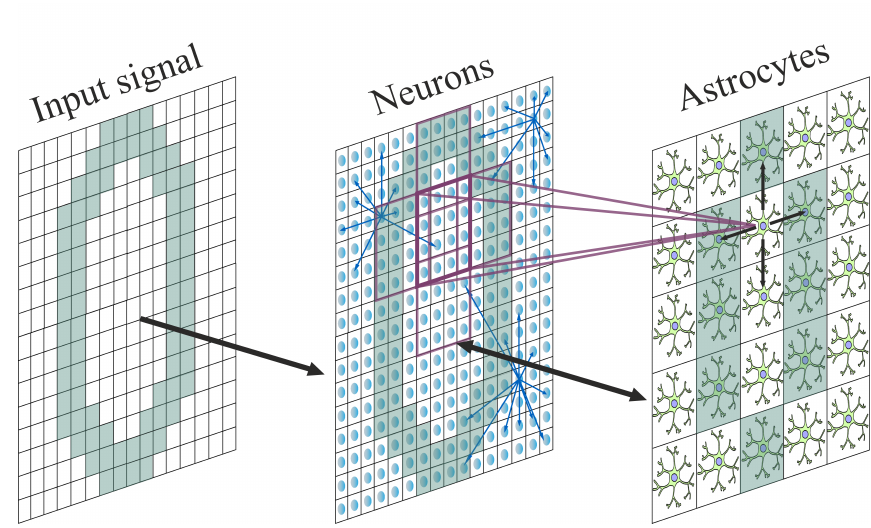
Figure 1. An illustrative diagram for the neuron–astrocyte